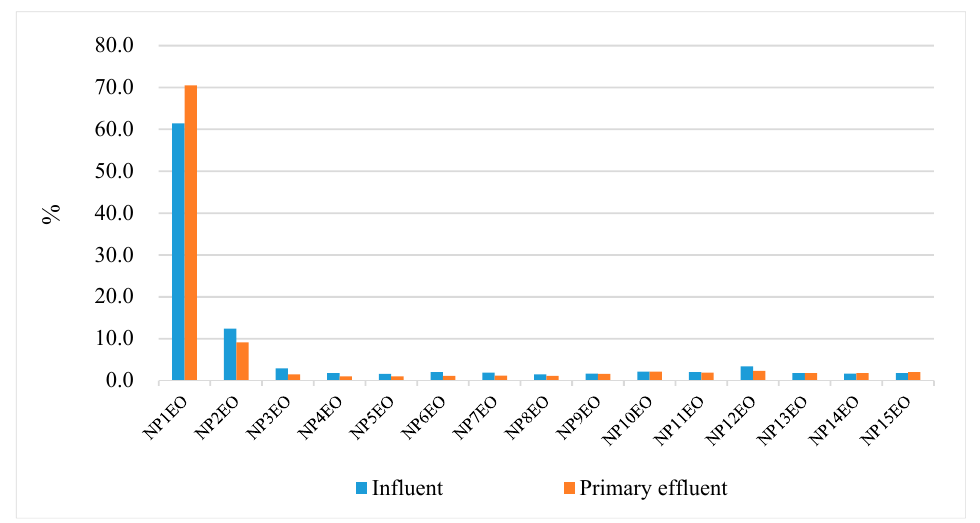
Figure 4. Distribution of nonylphenol ethoxylates for F2.